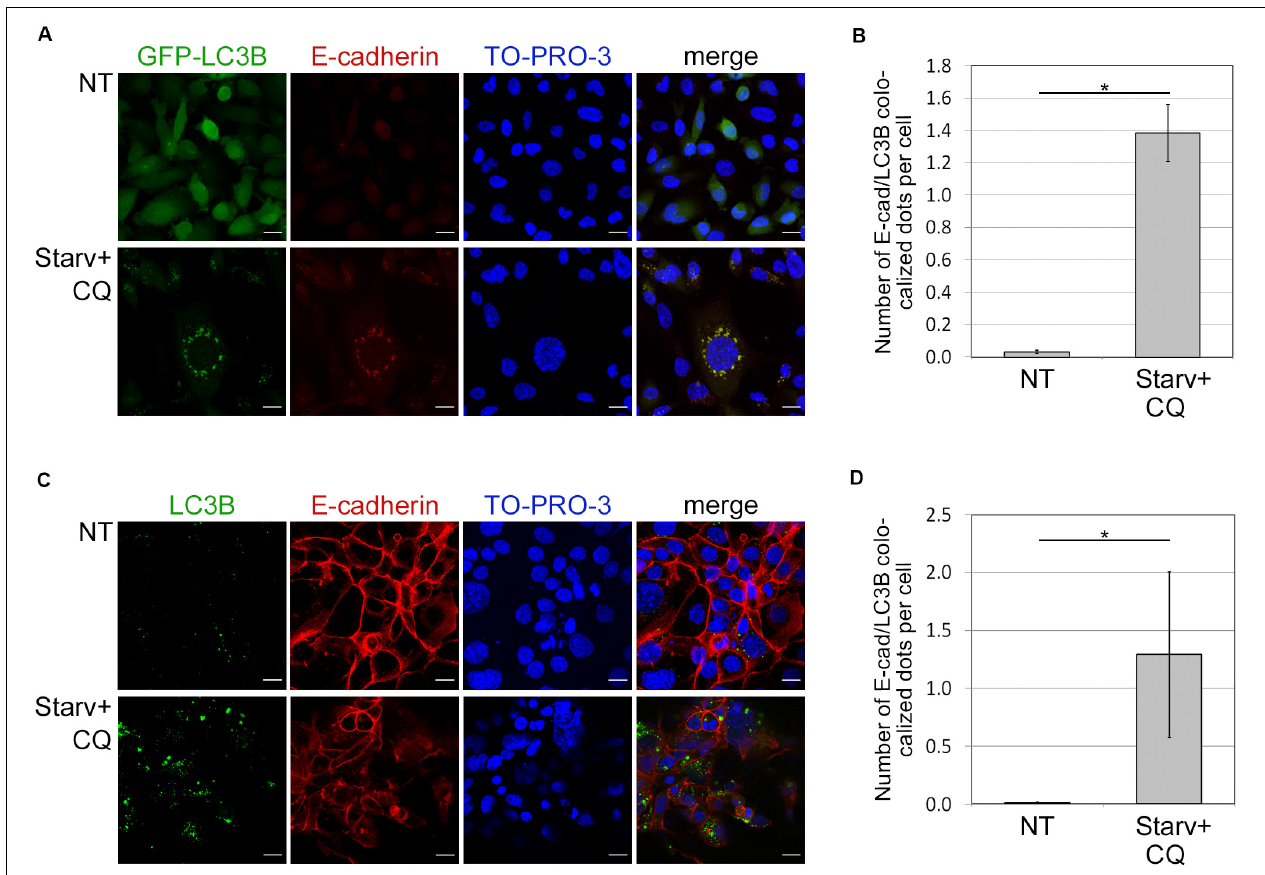
FIGURE 3 | Colocalization of E-cadherin and the autophagosomal LC3B. (A) MDA231 cells expressing GFP tagged form of LC3B (GFP-LC3B) were either grown in standard conditions (NT) or starved in the presence of CQ (Starv+CQ) for 8 h. Cells were stained with anti-E-cadherin/Alexa594 antibodies and analyzed by confocal microscopy. Nuclei were labeled with TO-PRO-3. Representative merge images are reported. (B) Quantification of GFP-LC3B and E-cadherin colocalized dots per cell measured in the experiments as in (A) . The analysis was performed as described in section “Materials and Methods.” (C) HCC1937 cells treated as in (A) and stained with anti-LC3B/Alexa488, anti-E-cadherin/Alexa549 antibodies, and TO-PRO-3. (D) Graph reported the quantification of the experiments carried out as in (C) . (B,D) At least 100 cells per sample were measured in three independent experiments. Graphs report the mean number of E-cadherin and LC3B colocalized dots per cell of at least 100 cells per sample measured in three independent experiments. Bars represent SEM; * p < 0.01 in unpaired t